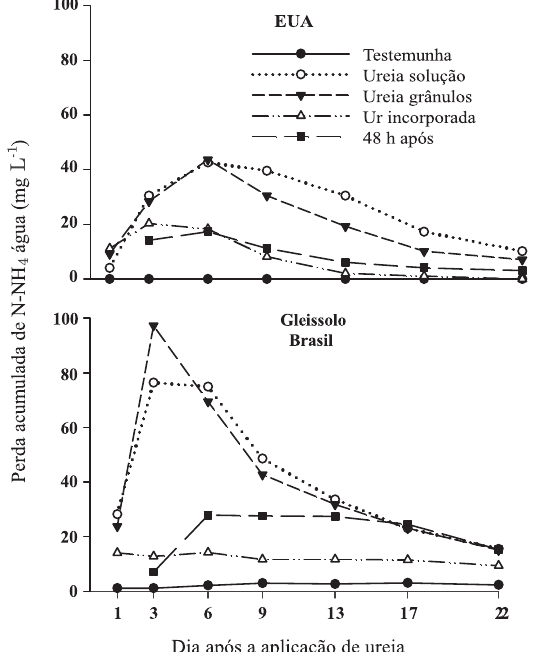
figura 2. concentração de amônio na água